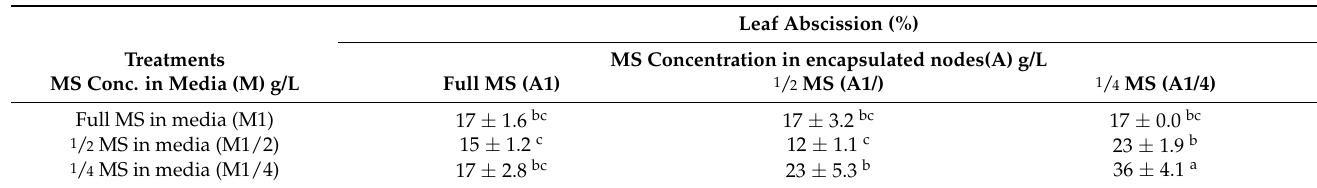
Table 4. Interaction of MS salts concentration in encapsulated sweet potato ( Ipomoea batatas L.) nodes (A) and growth media (M) on plantlets leaf